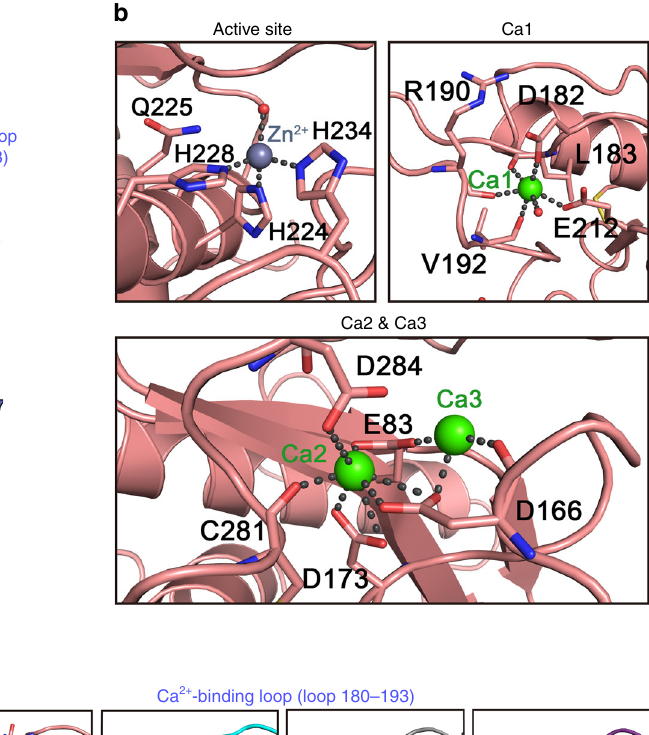
Of the 19 ADAMTS family members, ADAMTS13 is the only member with a known role in blood plasma. The importance of its physiological role is highlighted by the severe thrombotic phenotype associated with its inherited or acquired de fi ciency 5